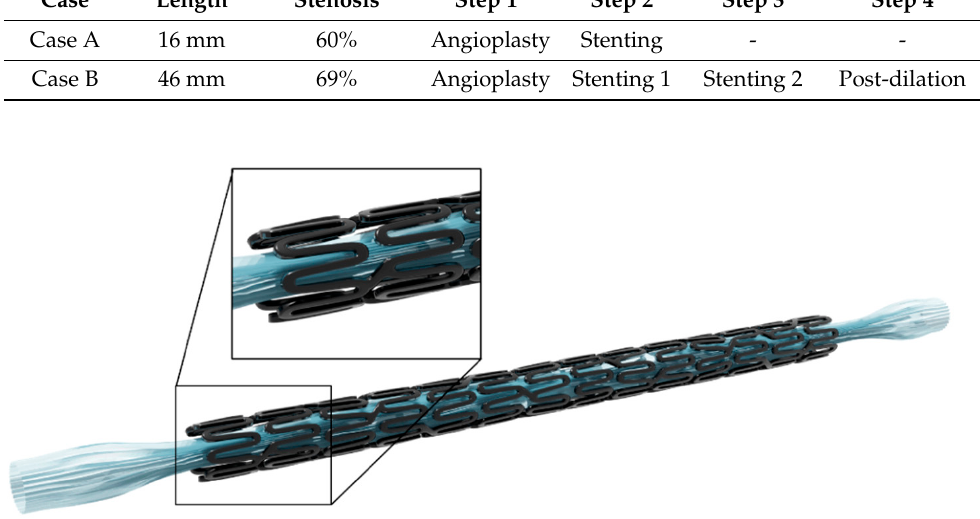
Figure 5. Virtual model of SYNERGY™ delivery system: stent and multi-wings balloon models after crimping simulation.